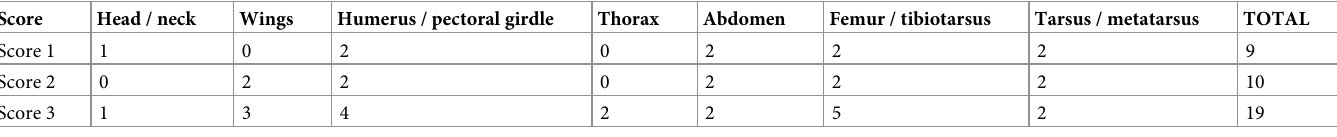
Table 1. Distribution of lead fragment scores in different body